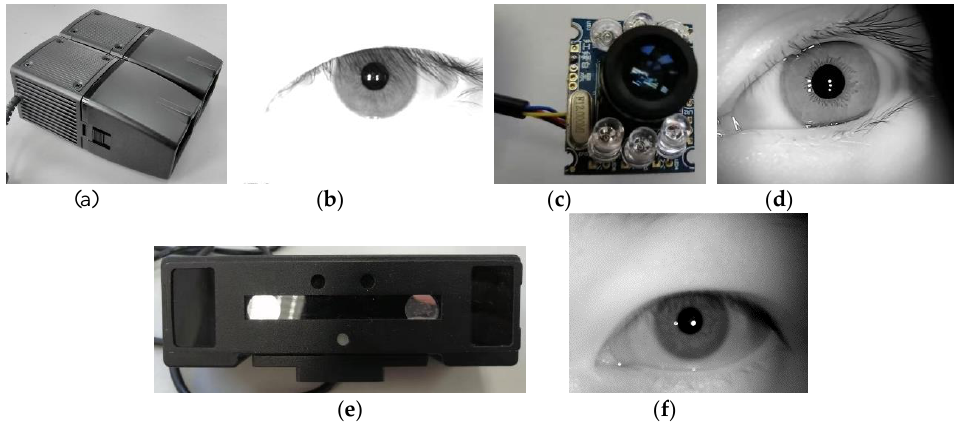
Figure 2. Eye acquisition sensors. ( a ) NIR acquisition sensor, ( b ) NIR acquisition sensor for ideal images, ( c ) ordinary optical acquisition sensor, ( d ) ordinary optical acquisition sensor for ideal images, ( e ) ordinary optical acquisition sensor for upgrading sensors, ( f ) ordinary optical acquisition sensor with upgraded sensors corresponds to ideal